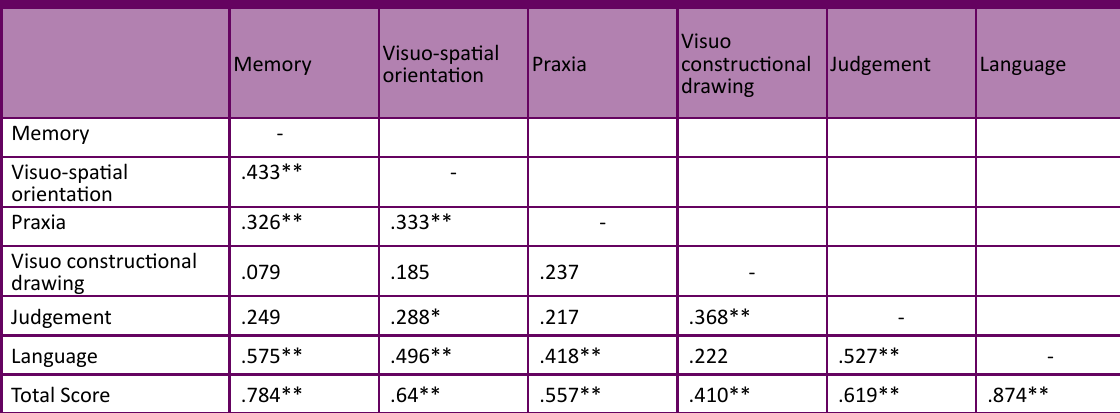
Table 3 – Correlation of RUDAS total and sub-scale scores